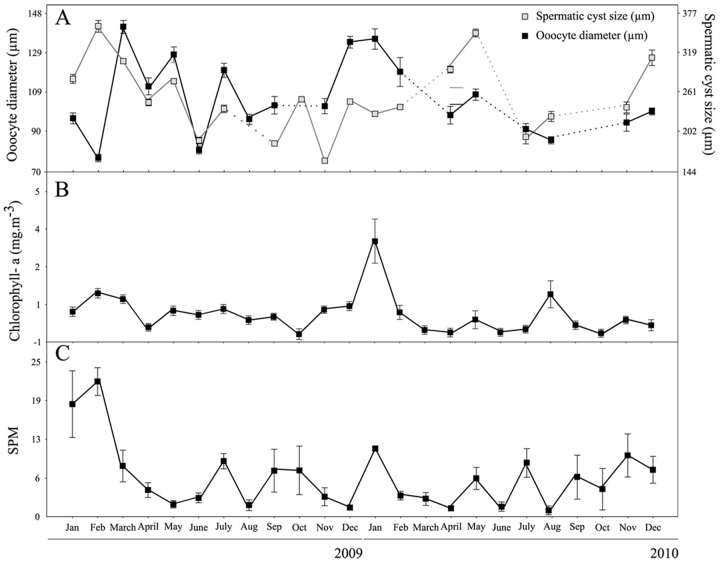
Oocytes and cysts size and environmental variation.(A) Mean oocyte feret diameter (μm) (black line) and average spermatic cyst size (μm) (dashed line). (B) Seasonal variation of Chlorophyll-a (mg.m-3) and (C) SPM (mg.m-3) data was collected by 4.7 l Niskin bottles at 5 depths (0; 5; 10; 20 and 30m) and determined by Schloss el at. (2012) Vertical bars indicate ± SE.